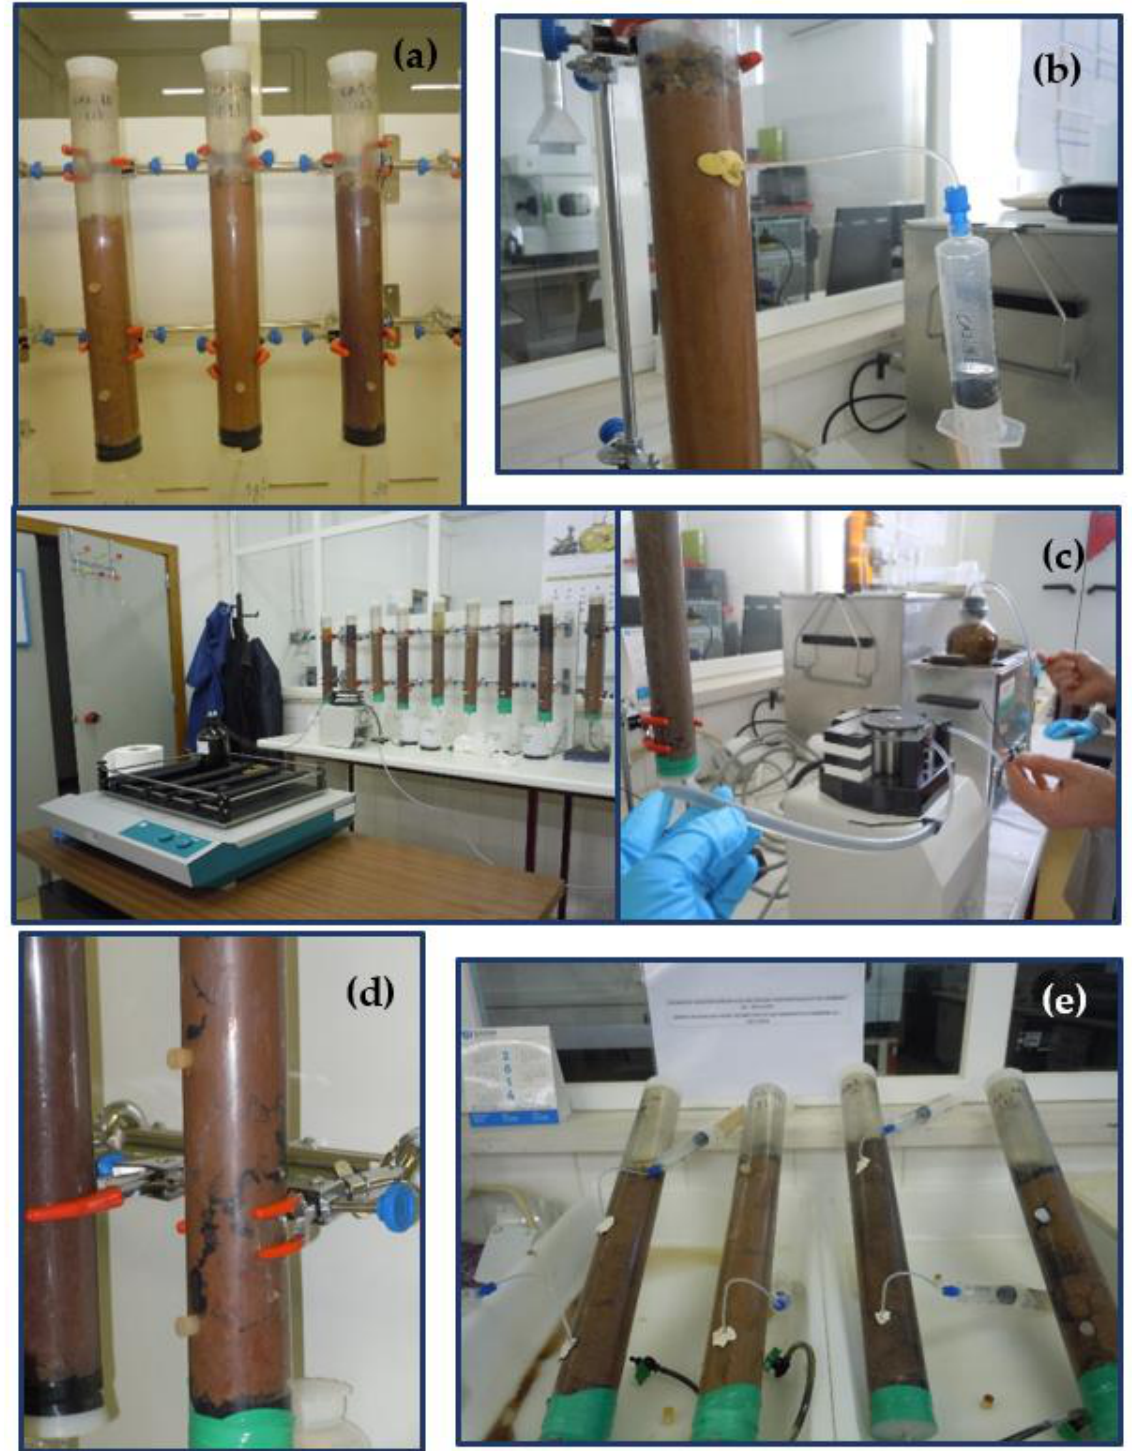
Figure 3. Steps of the injection test with zero-valent iron nanoparticle (nZVI) in metal-contaminated sedimentary materials: ( a ) columns with the saturated samples, ( b ) extraction of the interstitial water before injection, ( c ) injection of the nZVI solutions (at three different concentrations) and deionized water (blank) into the sample columns, ( d ) appearance of the samples after injection of the nZVI solution, and ( e ) extraction of the interstitial water after nZVI injection and for various time periods, from 24 h after injection, up to 4